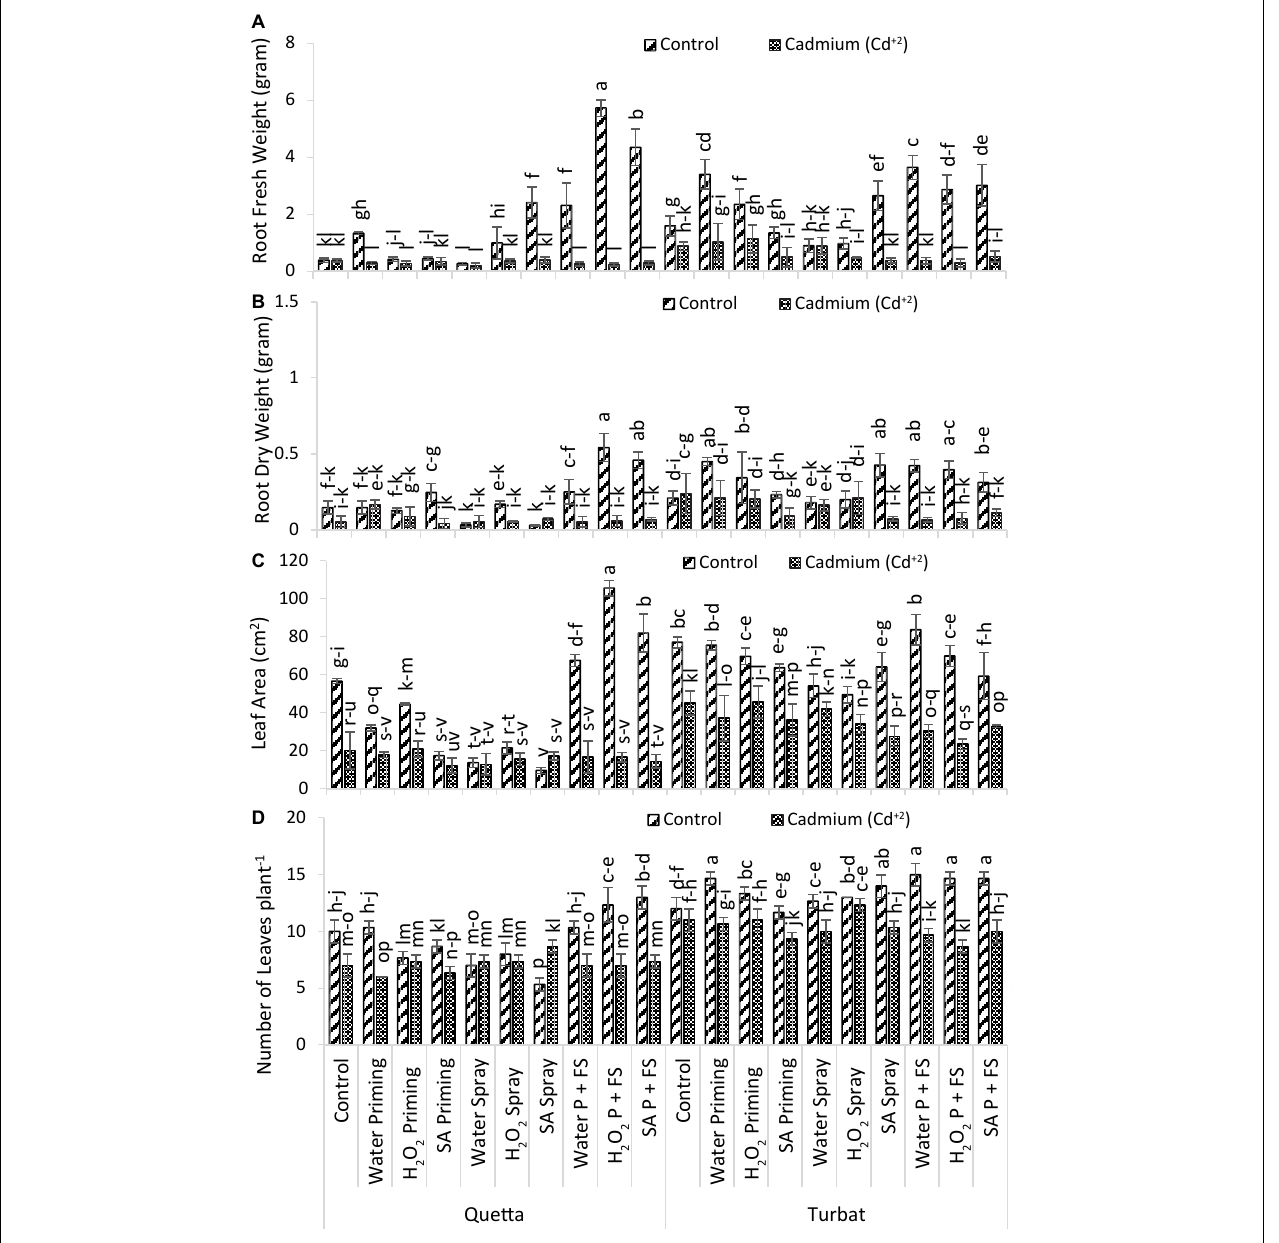
FIGURE 3 | Growth parameters; root fresh weight (A) , root dry weight (B) , leaf area (C) , no of leaves plant - 1 (D) of milk thistle as affected by SA and H 2 O 2 treatment grown at Quetta and Turbat under cadmium stress. The same letters on graphs represent statistically similar effect ( p <